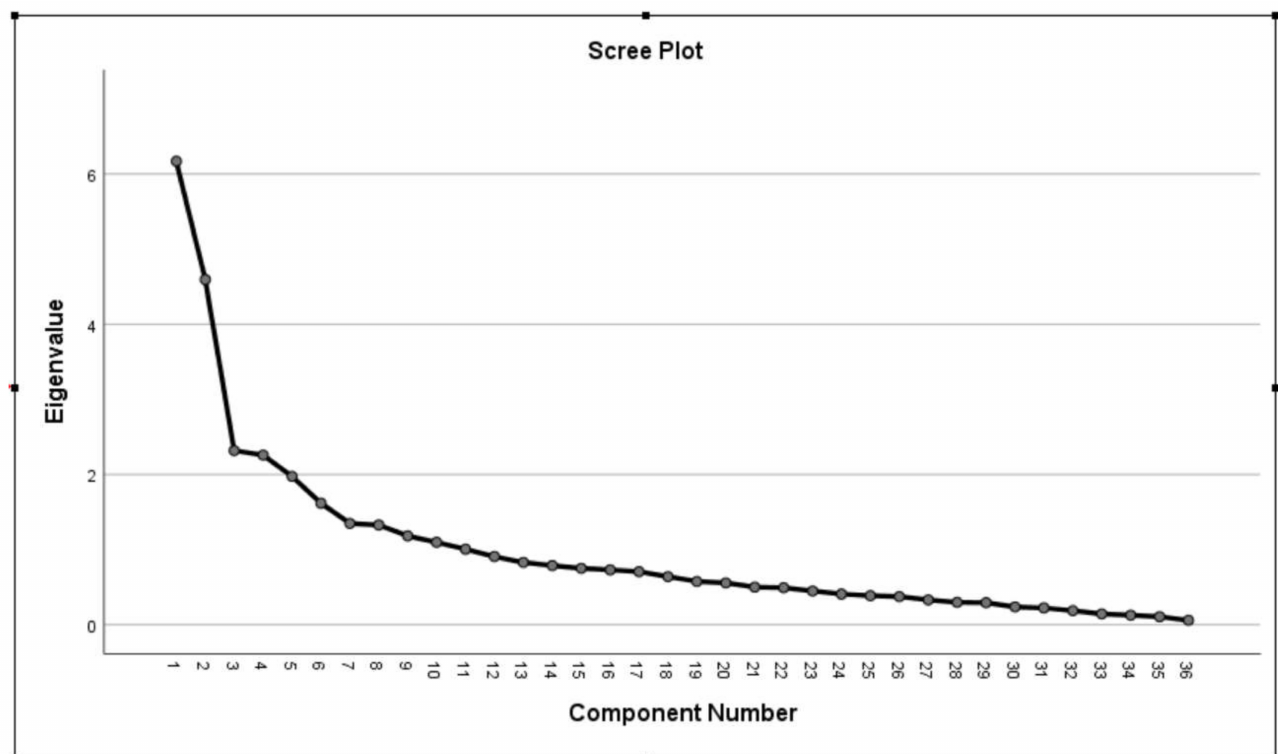
Figure 5. Factors distinguished on the basis of the Scree